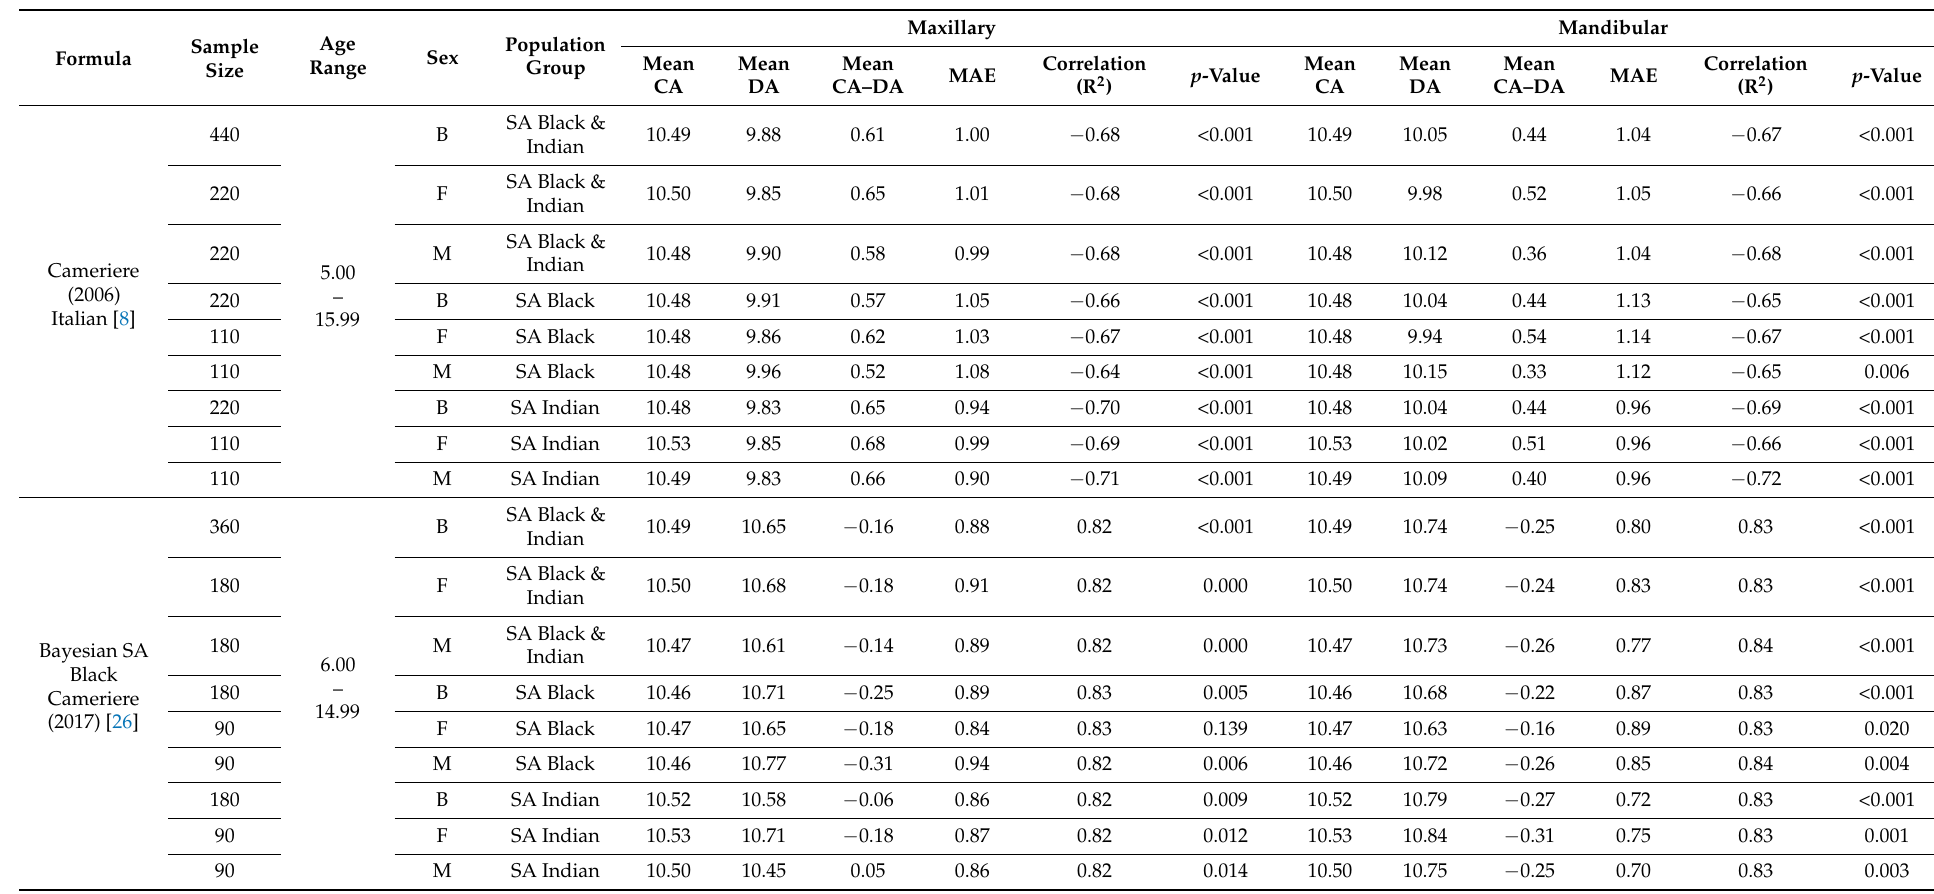
Table 2. Mean Chronological and Dental age calculated using the Cameriere formulae for South African Black and Indian population group of KZN (in years).